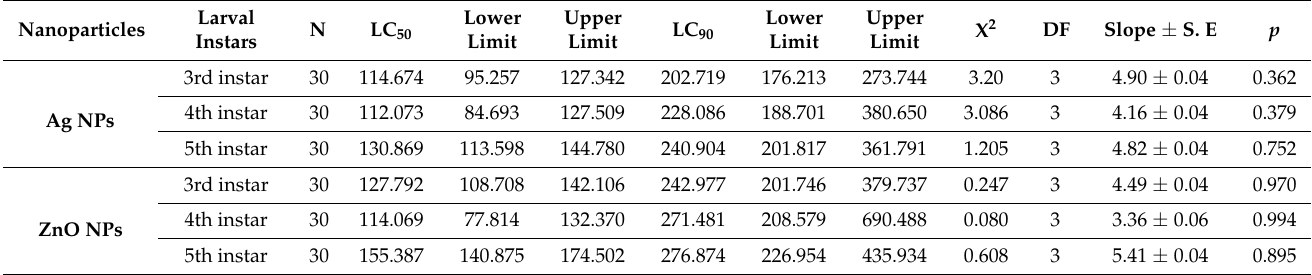
third, fourth, and fifth instar larvae against silver NPs were observed, i.e., 114.67, 112.07 and 130.89 ppm, respectively, while LC 90 values of 202.71, 228.08 and 240.90 ppm were observed, respectively. In the same way, LC 50 values of third, fourth and fifth instar larvae against zinc oxide NPs were observed at 127.79, 114.069 and 155.38 ppm, respectively, while LC 90 values were observed at 242.97, 271.48 and 276.87 ppm, respectively (Table 1). Table 1. Effect of various concentrations of synthesized silver and zinc oxide NPs coated with neem extract on the mortality of different larval instars of H. armigera.